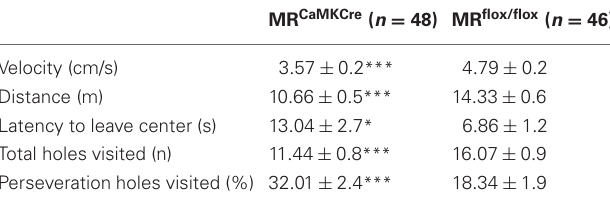
Table 1 | Behavioral data from the free exploration trial (FET).